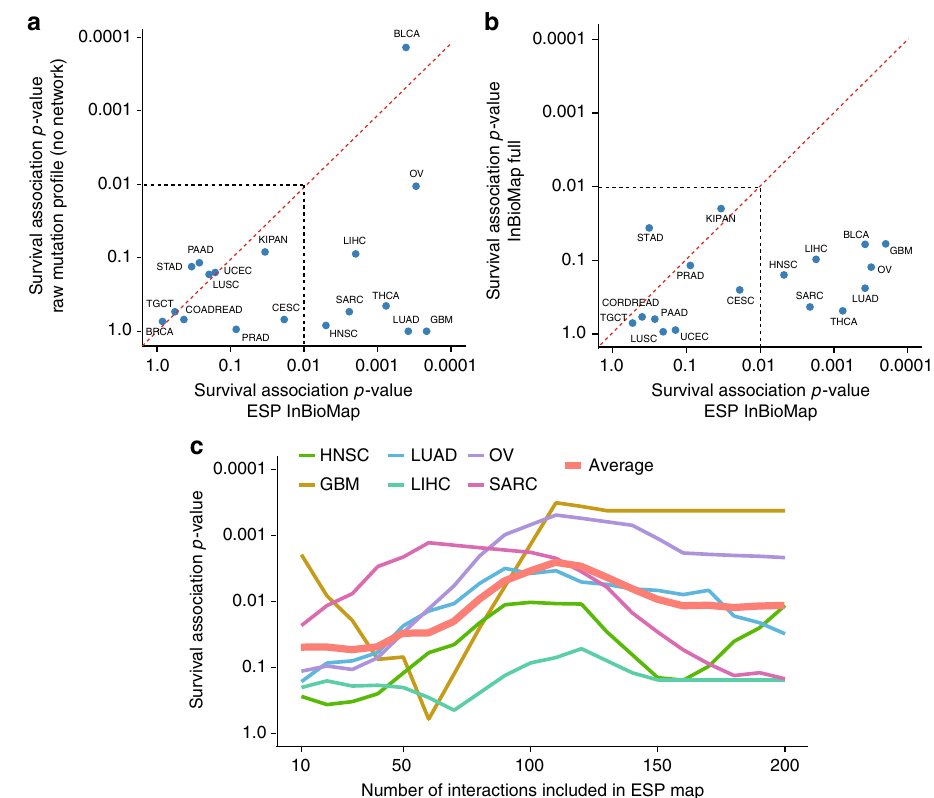
Fig. 5 Evaluation performance of different input sources. For each method, performance was evaluated as the prognostic ability of the resulting subtypes, i.e., the association of subtype with patient overall survival computed by log-rank p -value of Cox regression. a ESP of InBioMap vs. ‘‘ Empty ’’ network. b ESP of InBioMap vs. Complete InBioMap. c Performance as the threshold number of Mutually Exclusive gene interactions increases from 10 to